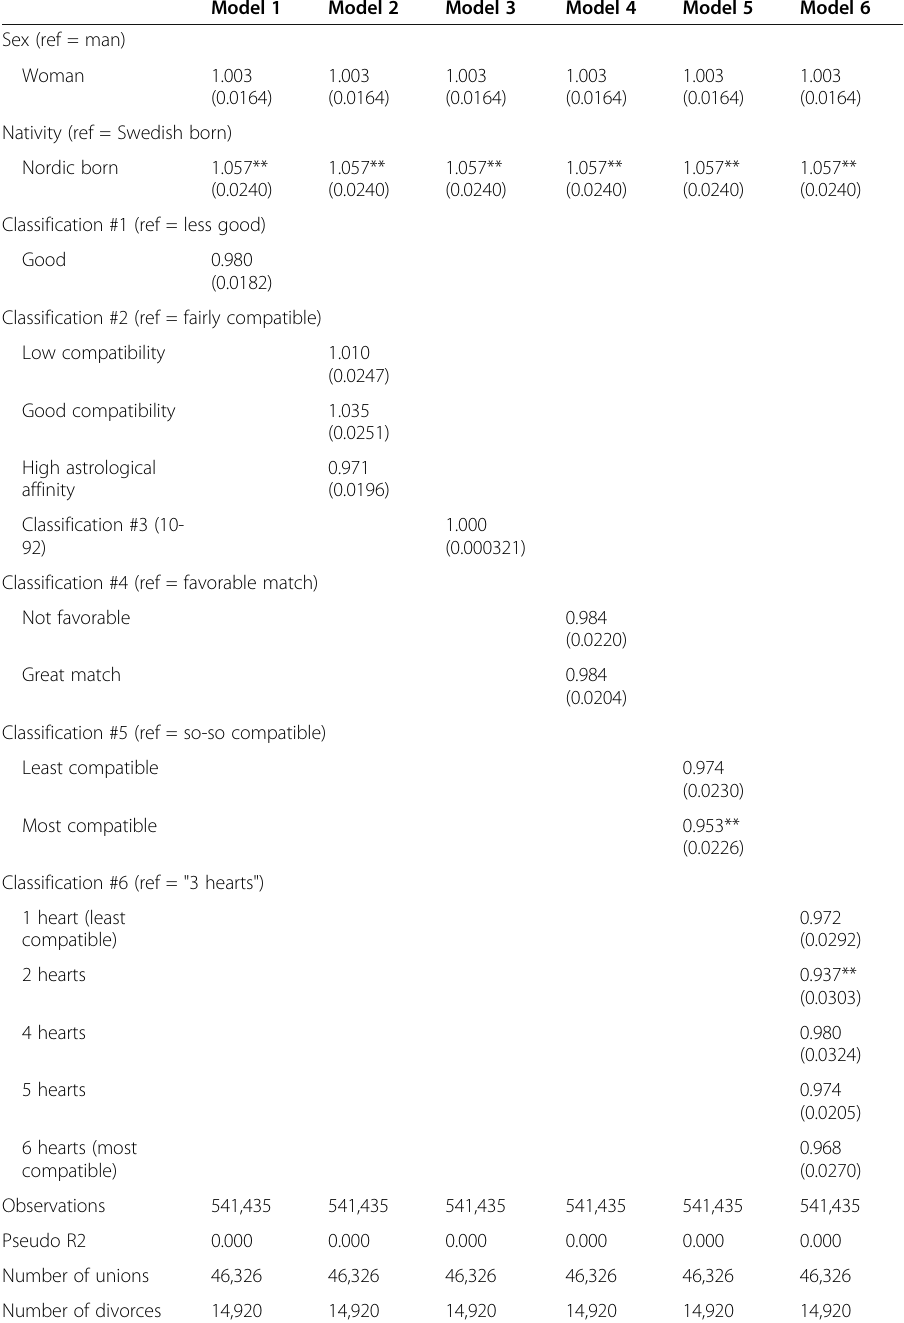
Table 4 Cox proportional hazards regression output (hazard